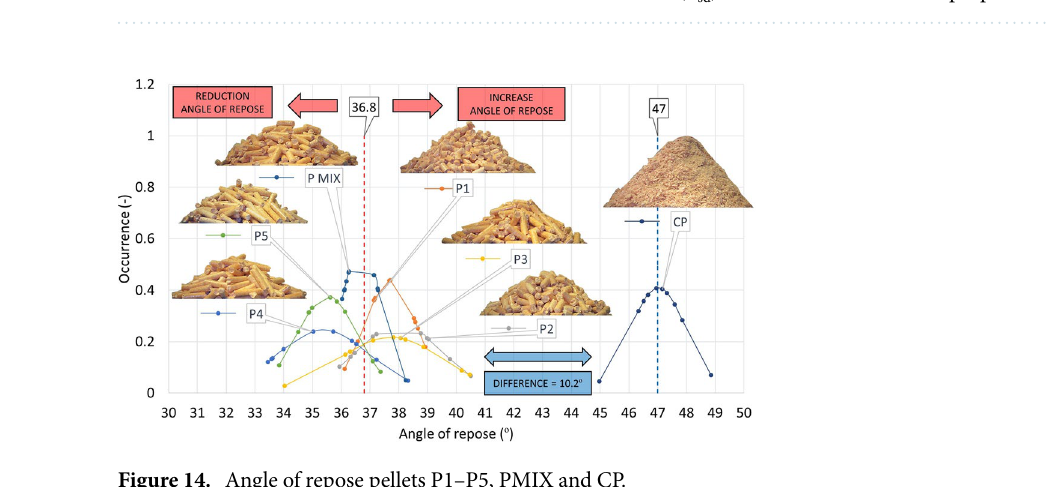
Figure 14. Angle of repose pellets P1–P5, PMIX and CP.